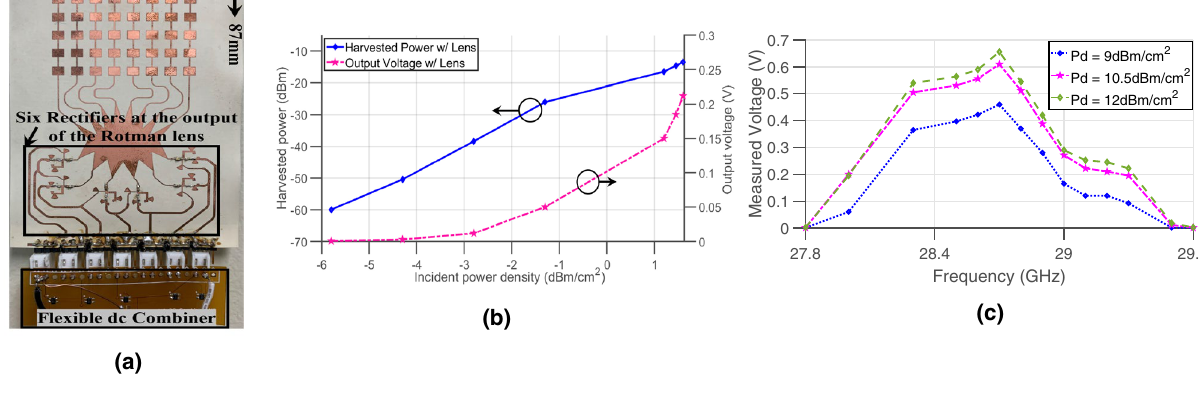
Figure 4. ( a ) Picture of the fully-flexible Rotman-based rectenna, ( b ) plot of the measured voltages and output powers versus incident power density for the Rotman-based rectenna and ( c ) plot of the measured voltages with respect to frequency for the Rotman-based rectenna.